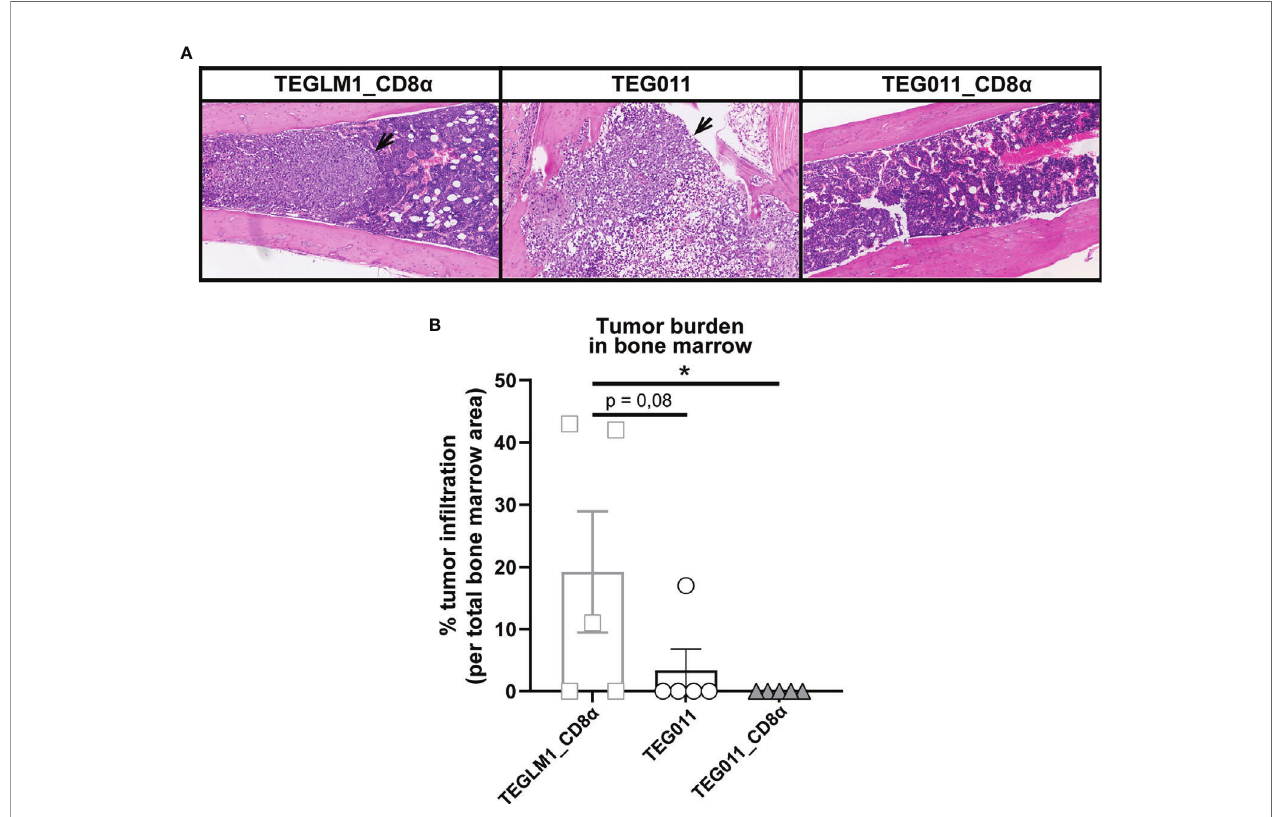
FIGURE 4 | TEG011_CD8 a effectively cleared tumor cells in bone marrow, without a signi fi cant difference in tumor in fi ltration observed in other major organs. (A) Representative pictures H&E stained of mouse bone marrow with the presence of neoplastic cells (black arrow) from individual mice of each treatment group (n = 5 mice/group). Magni fi cation: 10×. (B) Percentage cases of tumor in fi ltration in mouse bone marrow for each treatment group (n = 5 mice/group). Calculation was performed by dividing the area covered by the tumor cells per the total area of bone marrow tissue visible in the section using ImageJ. Data are shown as mean ± SEM (*P < 0.05) calculated by non-parametric Kruskal-Wallis